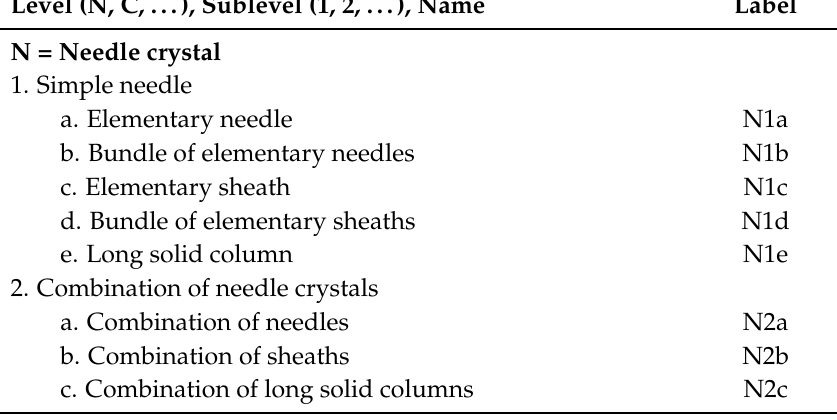
Table A1. Updated